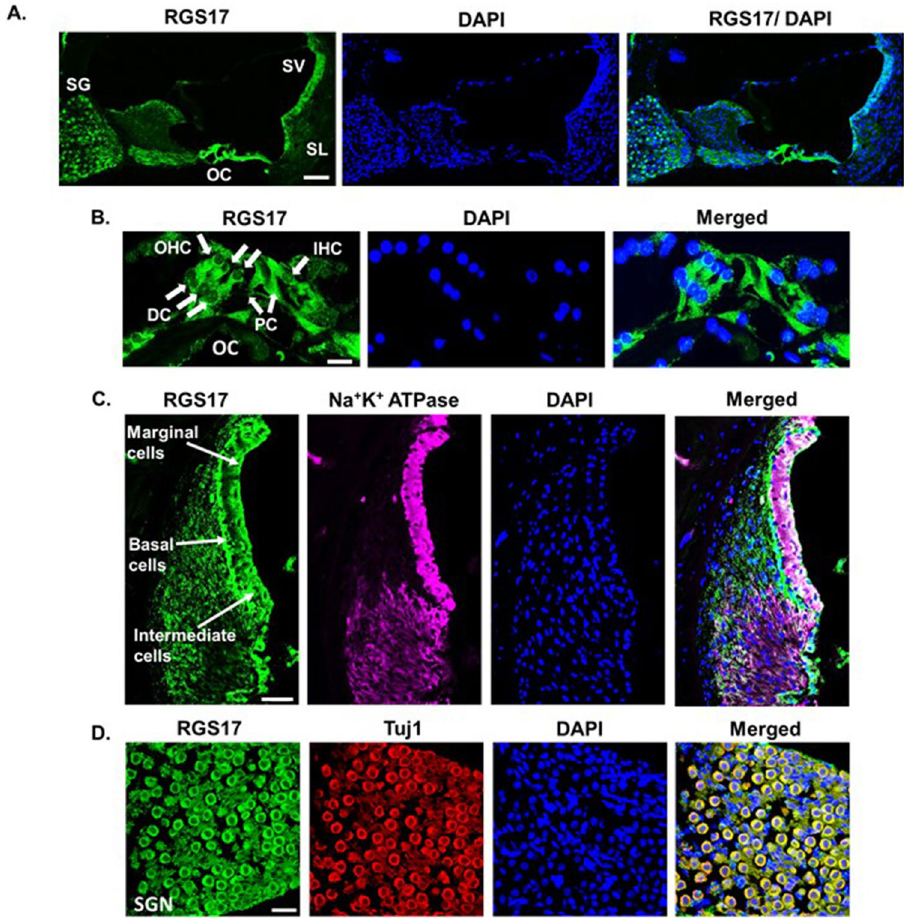
Figure 1. Distribution of RGS17 in the rat cochlea. Naïve male Wistar rats were used for the collection of cochleae. Collected cochleae were fixed with 4% PFA, cryo-frozen and processed for mid-modiolar sectioning using cryostats. Mid-modiolar section was immunolabeled with RGS17 (green) and DAPI (blue). ( A ) Significant immunolabelling of RGS17 observed in the rat cochlea. ( B ) Expression of RGS17 was observed in OHCs, IHC, supporting cells: DCs, IPC and OPC. ( C ) Co-immunolabelling with Na + K + ATPase (magenta) shows expression of RGS17 in the lateral wall of the cochlea. Positive immunofluorescence was seen in basal, marginal, intermediate cells and SL. ( D ) Co-staining with Tuj1 (red) shows RGS17 expression in cochlear neuronal cells, SGNs (Scale 50